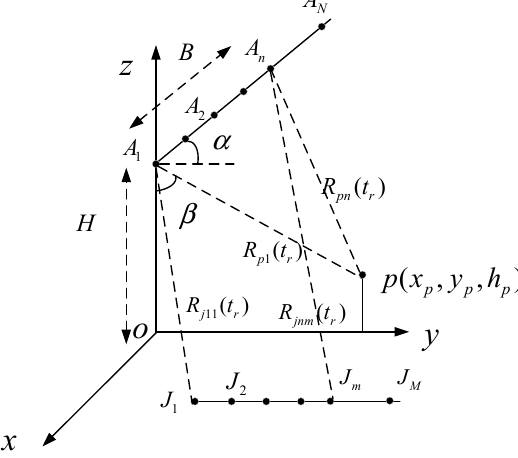
Figure 1. Geometry of single-pass multibaseline interferometry synthetic aperture radar (InSAR) deception jamming.